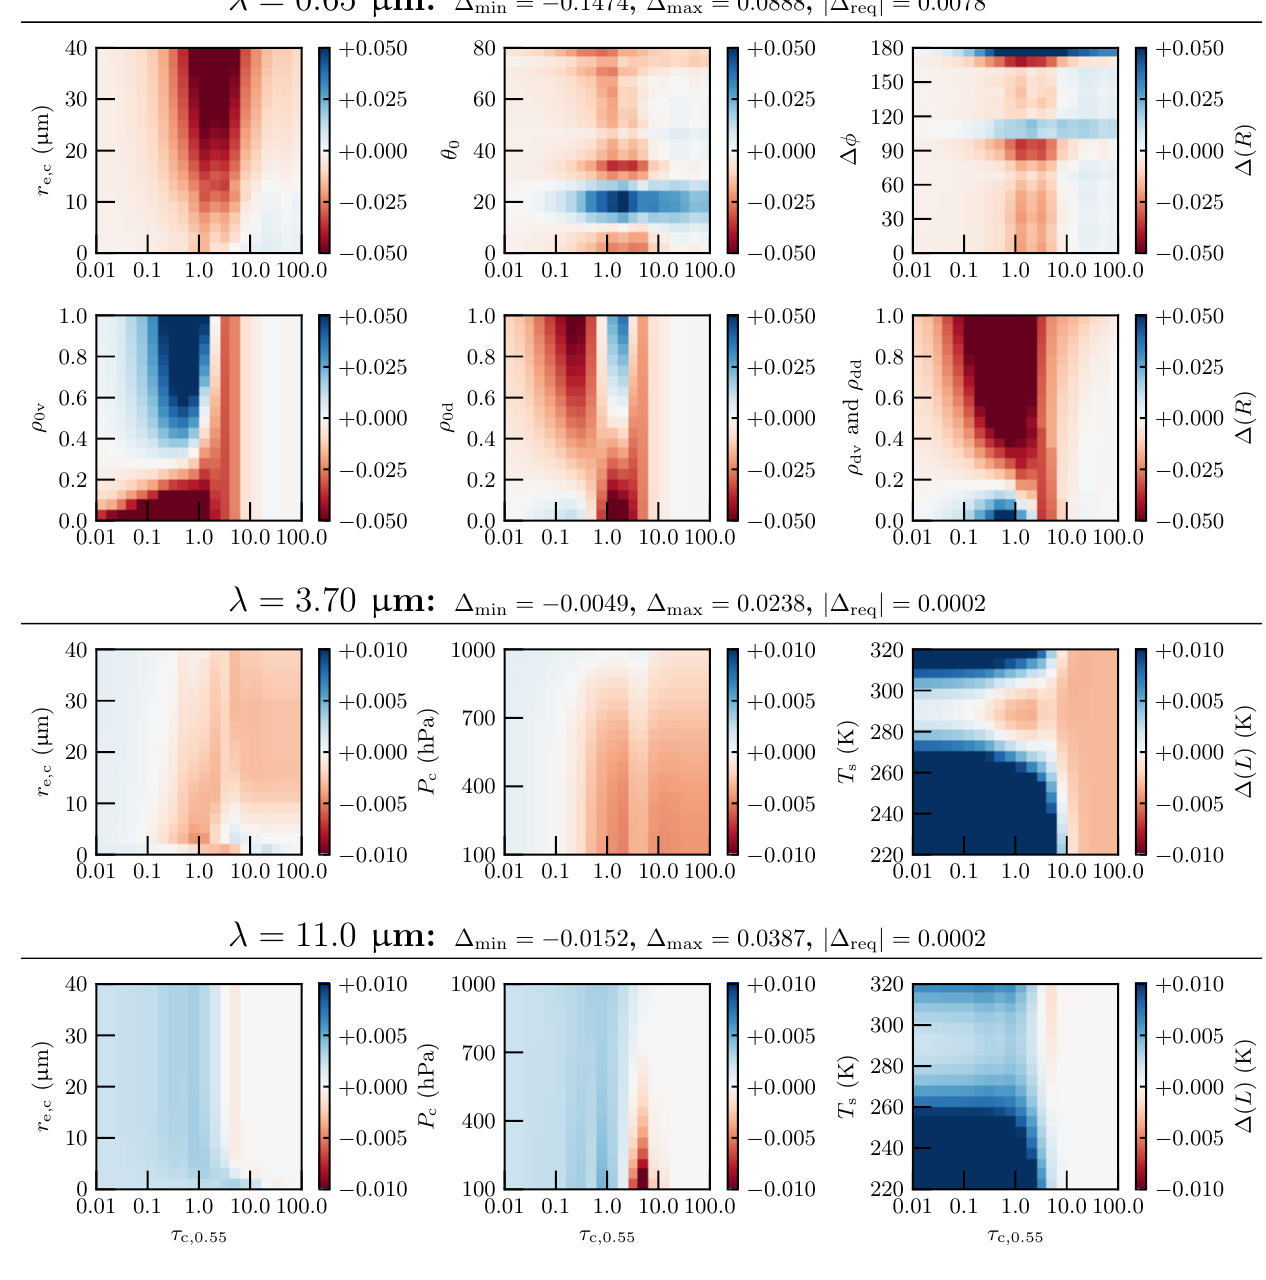
Figure 3. Fractional differences (cid:49)(x) , where x is either reflectance R or radiance L , between the reference forward model and the fast forward model for liquid water cloud as a function of optical thickness τ 0 . 55 , c versus effective radius r e , c (µm), solar zenith angle θ 0 , relative azimuth angle (cid:49)φ , bidirectional surface reflectance ρ 0v , directional–hemispherical surface reflectance ρ 0d and a combination of hemispherical–directional and bihemispherical surface reflectance ρ dv + ρ dd for wavelength λ = 0 . 65 and effective radius r e , c (µm), cloud top pressure p c (hPa) and surface temperature T s (K) for 3.70 and